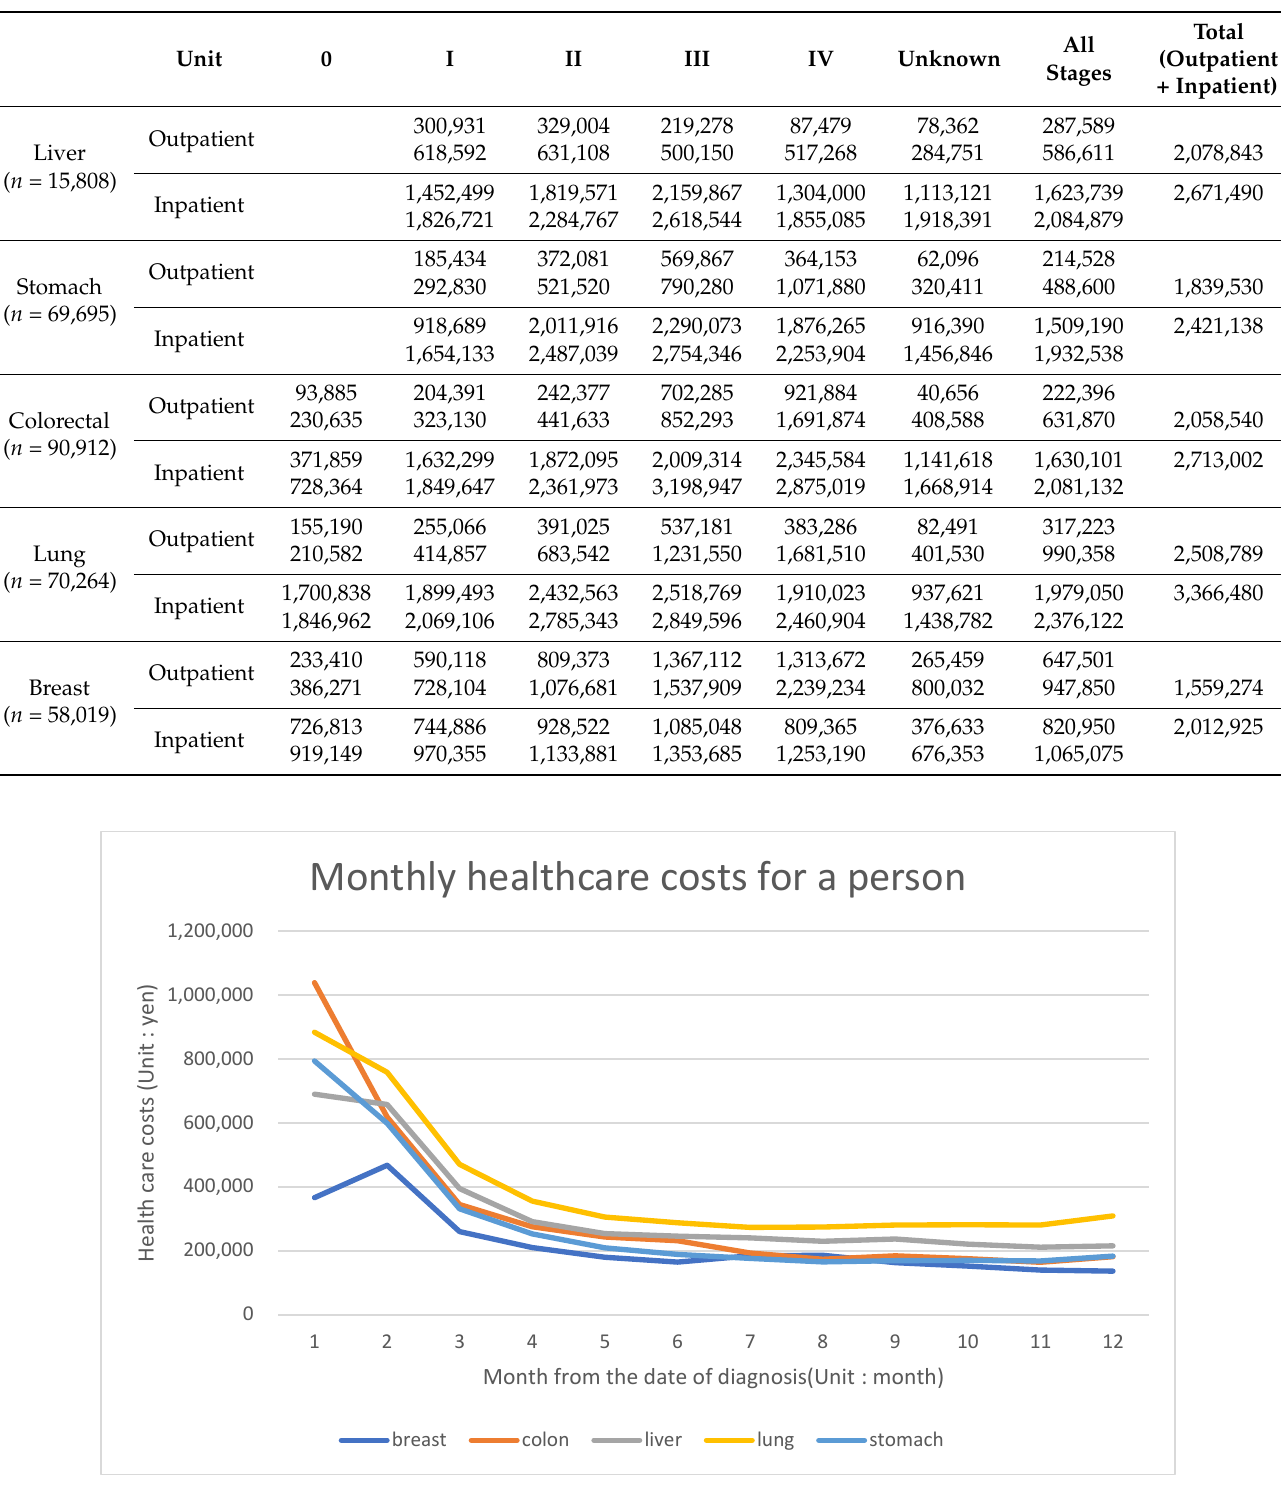
Figure 1. Monthly healthcare cost of each of the five major cancers per-patient.